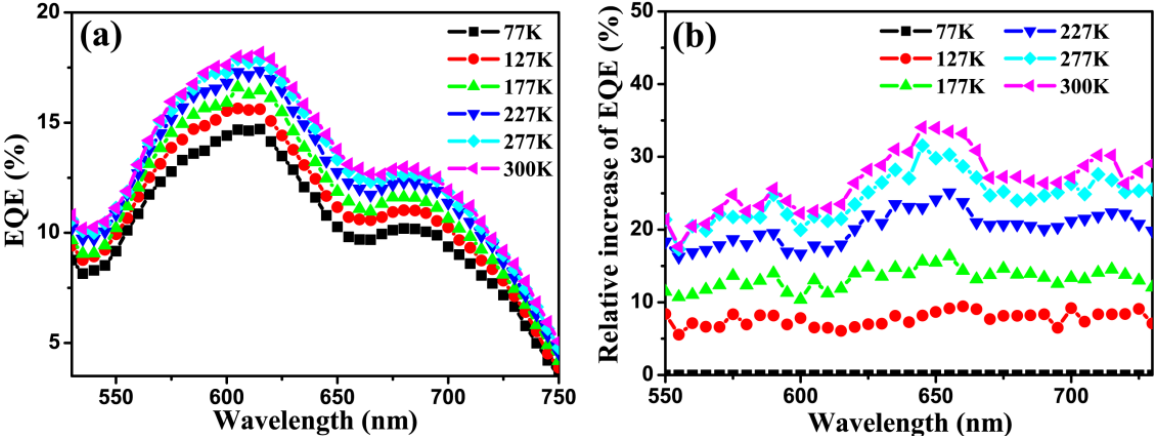
Figure 3. ( a ) EQE of the developed device at various temperatures. ( b ) Relative variation of EQE for different temperatures with the EQE at 77 K being chosen as